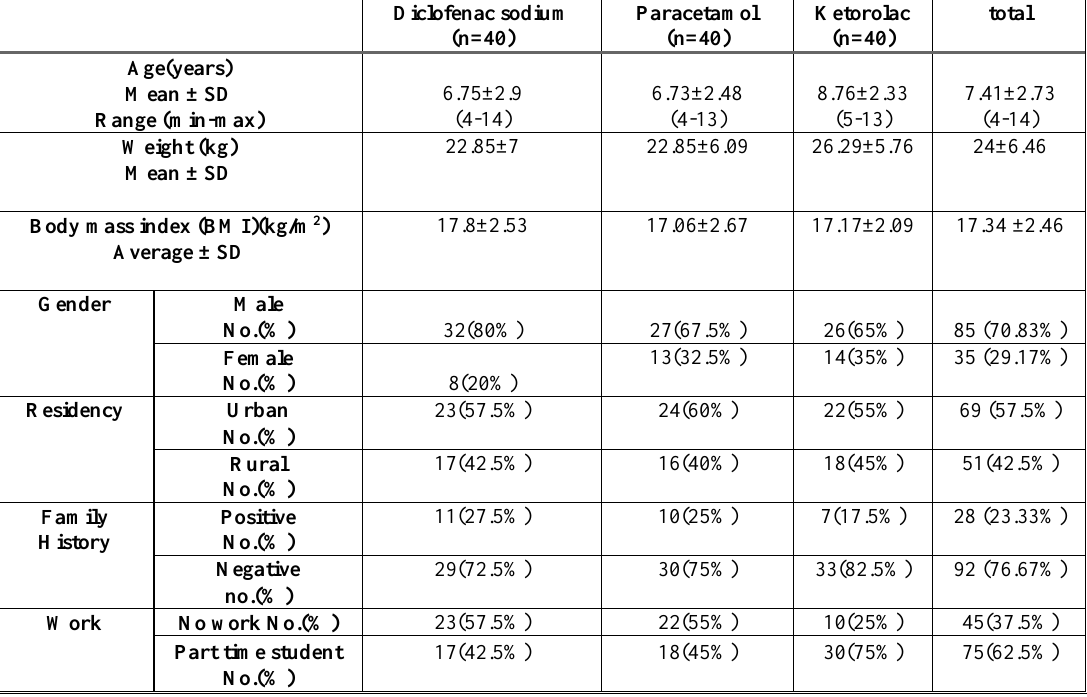
Table 1. Demographic characteristics of the study